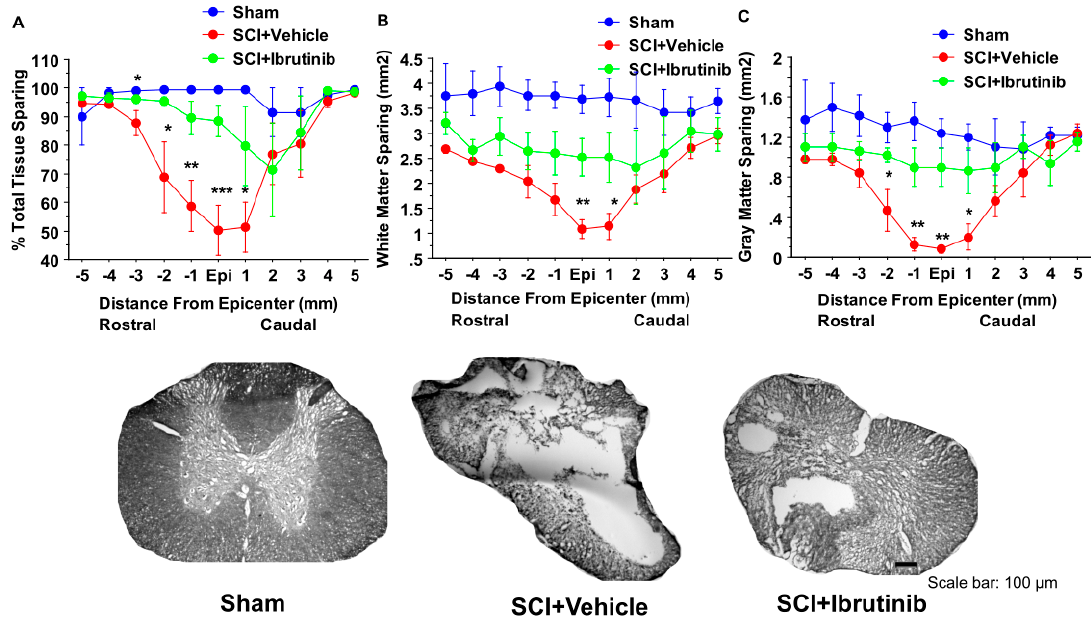
Figure 8. Effects of the 2 ‒ week treatment with Ibrutinib on lesion epicenter and spread of tissue damage after Scheme 2. Two ‒ week treatment with Ibrutinib resulted in significant increases in